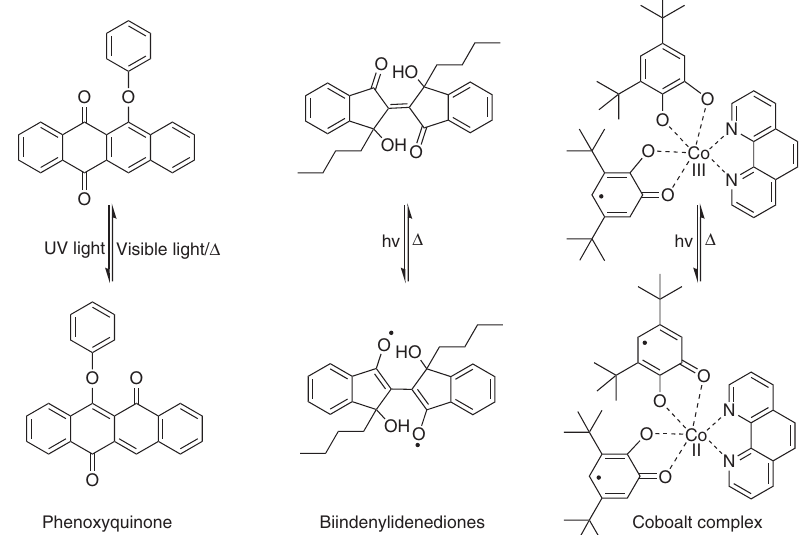
Figure 6 | Potential interesting photochromic molecules. These molecules have not been combined so far with carbon-based nanomaterials, which can be used for specific applications. Intramolecular transfer of phenoxyquinone for sensing (ref. 130). Photo-induced radical formation of biindenylidenediones (ref. 131) or photo-induced valence tautomerization of cobalt complexes (ref. 132) for spintronics. The three examples proposed represent basic chemical structures, which can be possibly redesigned with different